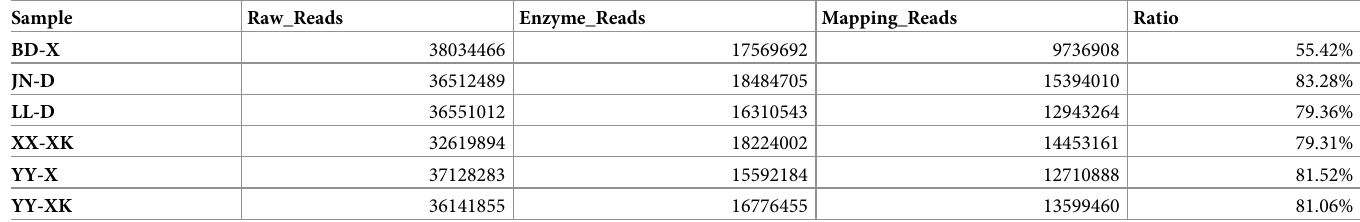
Table 2. Sequencing statistics.